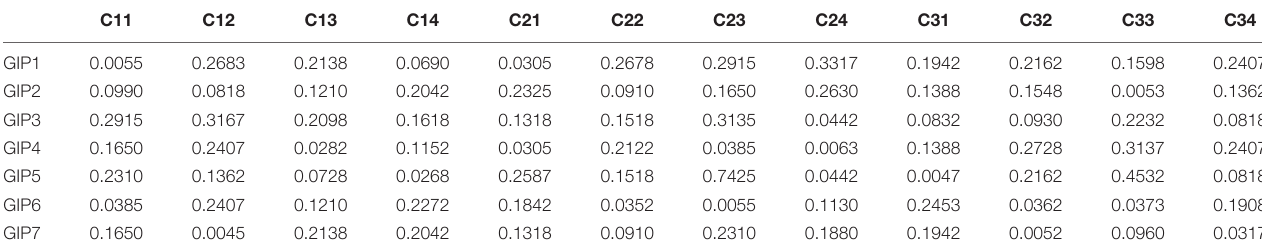
TABLE 5 | The matrix of defuzzification given by DGI experts.